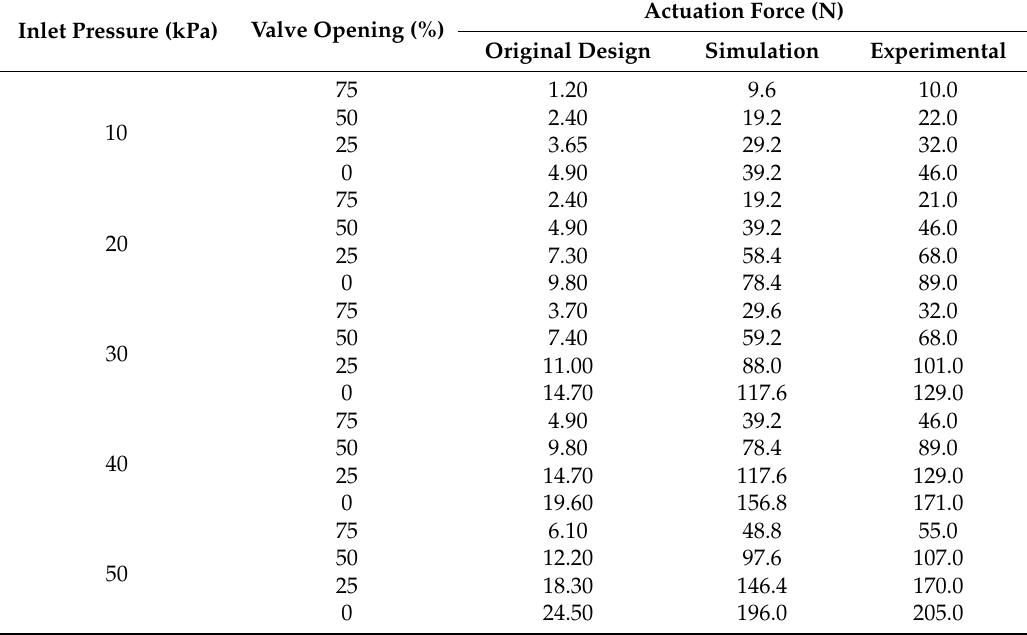
Table 4. Actuation force